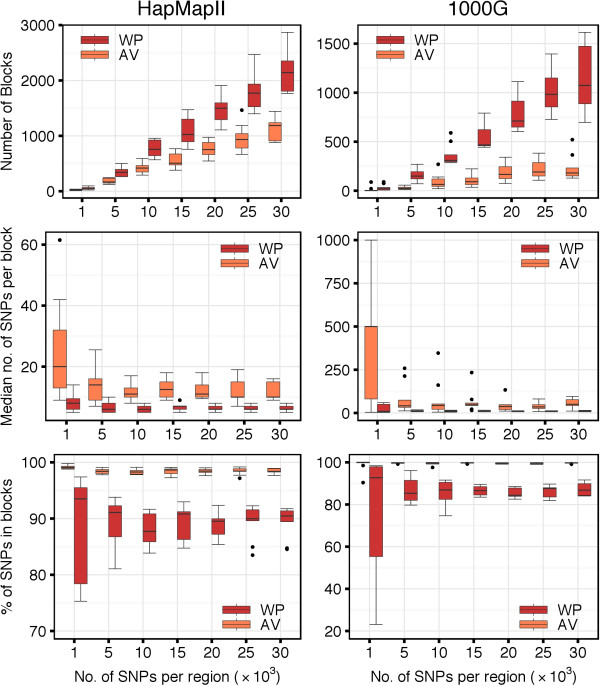
Haplotype block characteristics of WP and AV methods. Top panels show the number of haplotype blocks per region, middle panels show the median number of SNPs per block, and bottom panels show the overall percentage of SNPs in haplotype blocks.